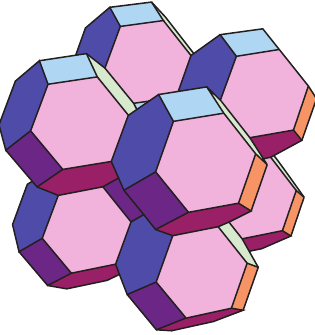
Figure 5. Body centered cubic arrangement of truncated octahedra or tetrakai- decahedra. Space-filling is achieved through BCC packing. The polyhedron located at the center of the BCC cell shares a hexagonal face with each one of the eight polyhedra located at the vertices.